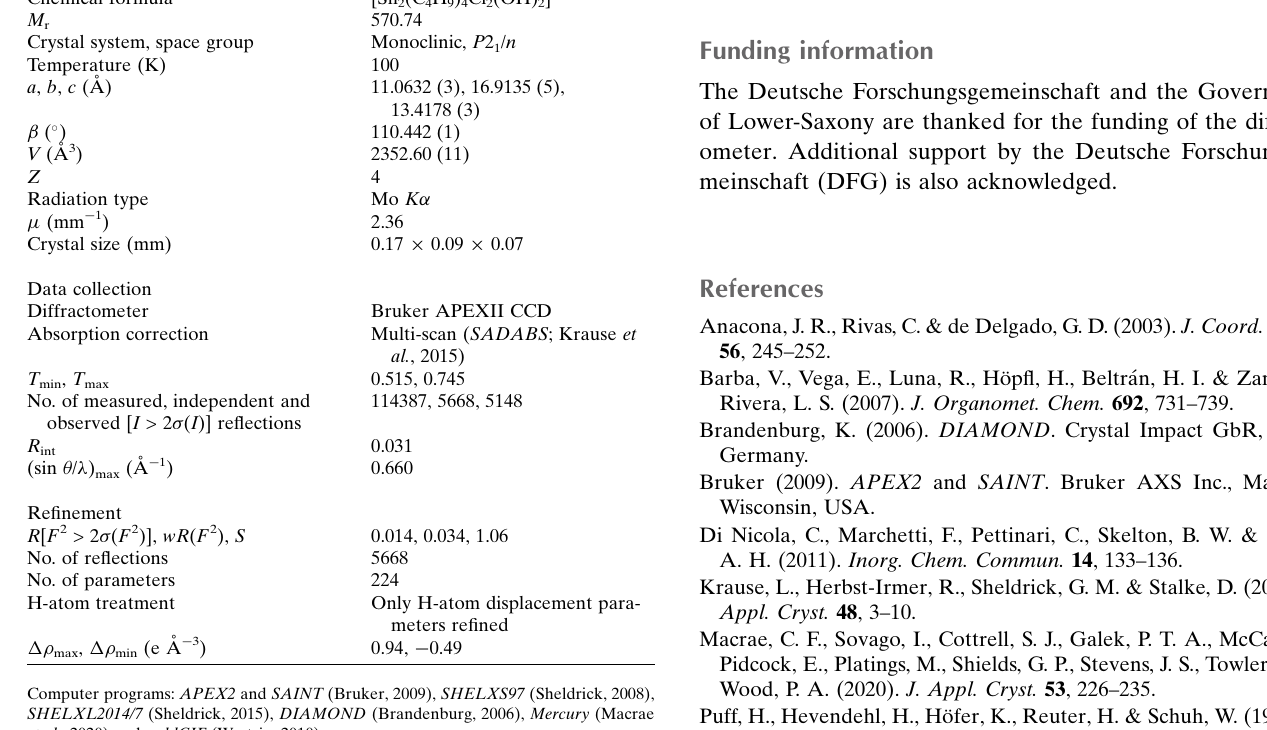
Crystal data Chemical